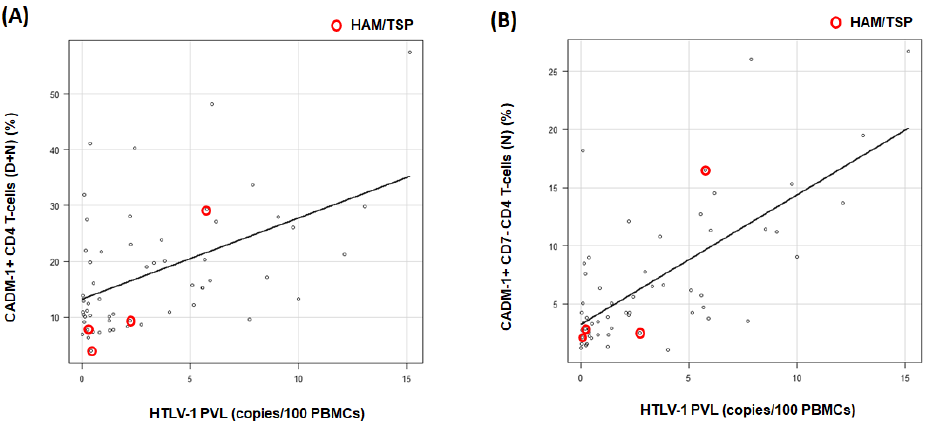
Figure 3. Scatter plot of the human T-cell leukemia virus type 1 (HTLV-1) proviral load (PVL) versus the percentage of CADM1-positive cells from the CADM1 versus CD7 plot. ( A ), X- and Y -axis indicates HTLV-1 PVL and the population of CADM1+ CD4+ T-cells (D + N region), respectively (R = 0.44). ( B ), X- and Y -axis indicates HTLV-1 PVL and the population of CADM1+ CD7 neg CD4+ T-cells (N region), respectively (R = 0.6). The plot with red circles indicated RA participants with HTLV-1-associated myelopathy/tropical spastic paraparesis (HAM/TSP). PBMCs: peripheral blood mononuclear cells.